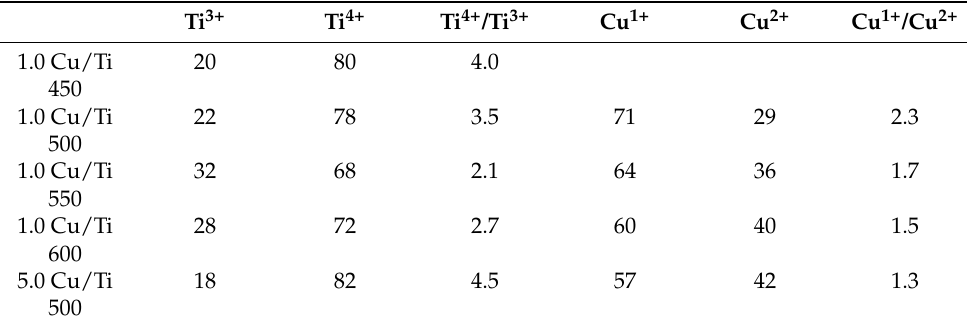
Table 2. Titanium and copper species ratios of the Cu/Ti